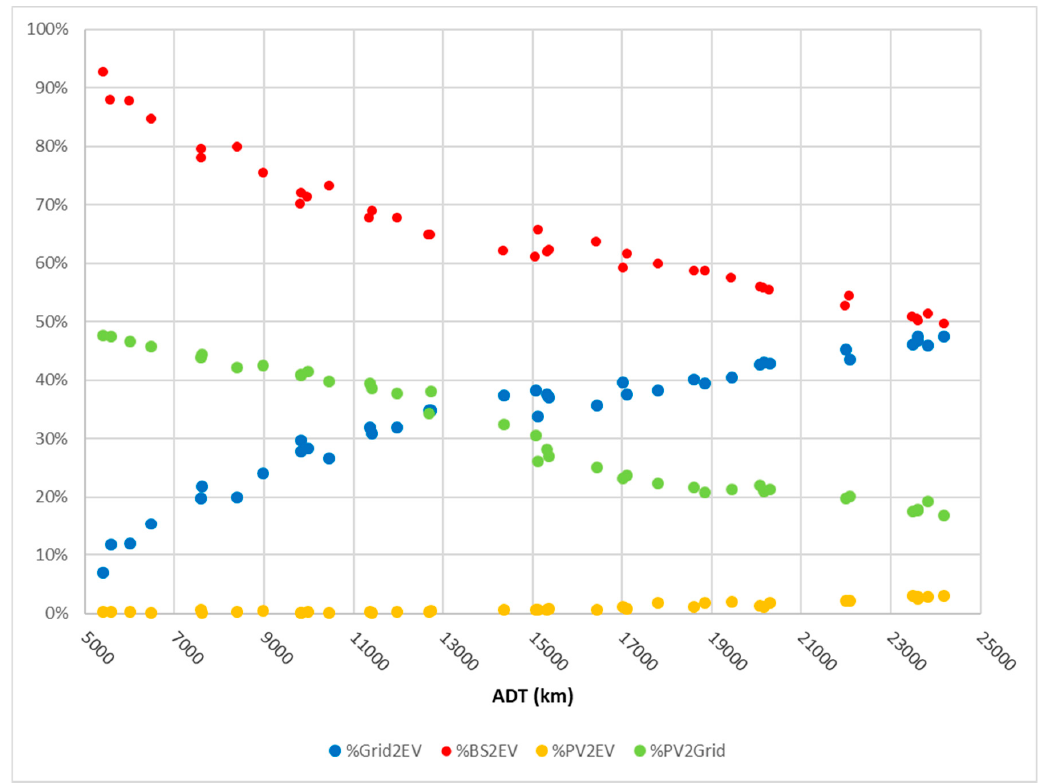
Figure 2. Energy source used to charge the EV and electricity discharged to the electrical grid, with varying ADT in the base-case scenario, without the solar-forecast-based strategy.